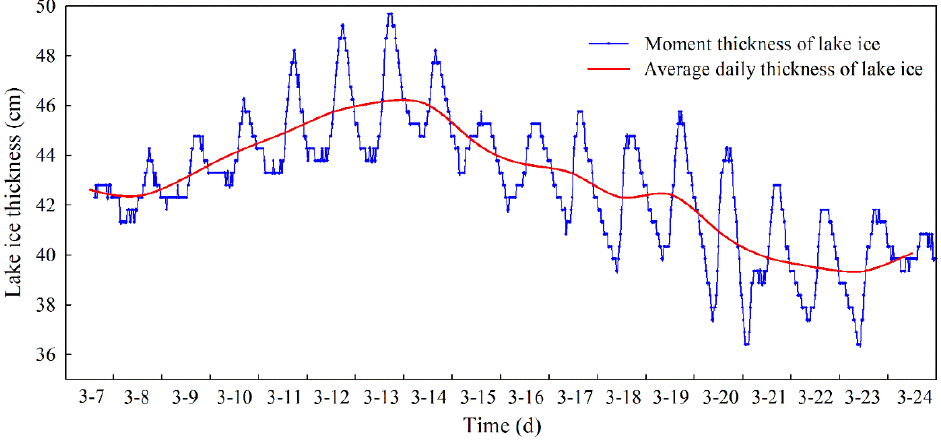
Figure 4. Variations of the moment and average daily thickness of lake ice.